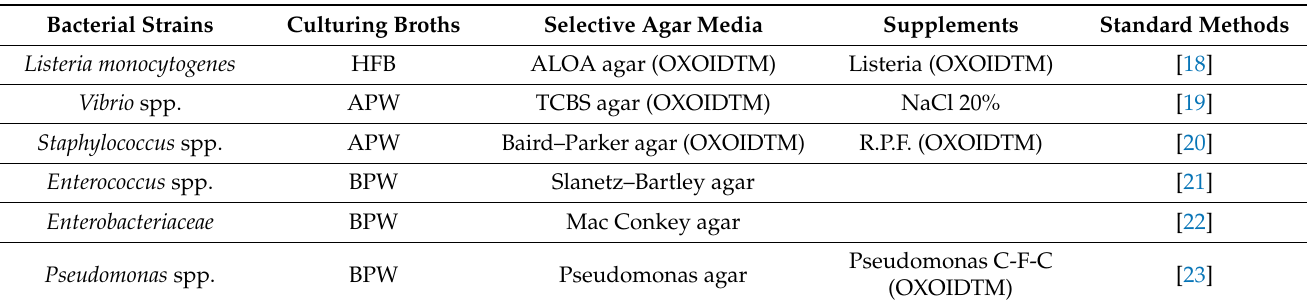
Table 1. Selective culturing agar and broth media for bacterial pathogens (according to the EU Reg. 2073/2005) used in the present